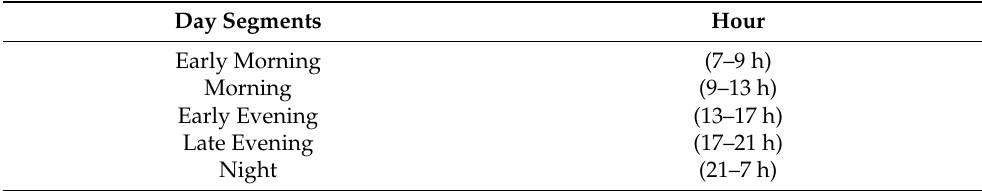
Table 3. Electricity consumption by 10 clusters.